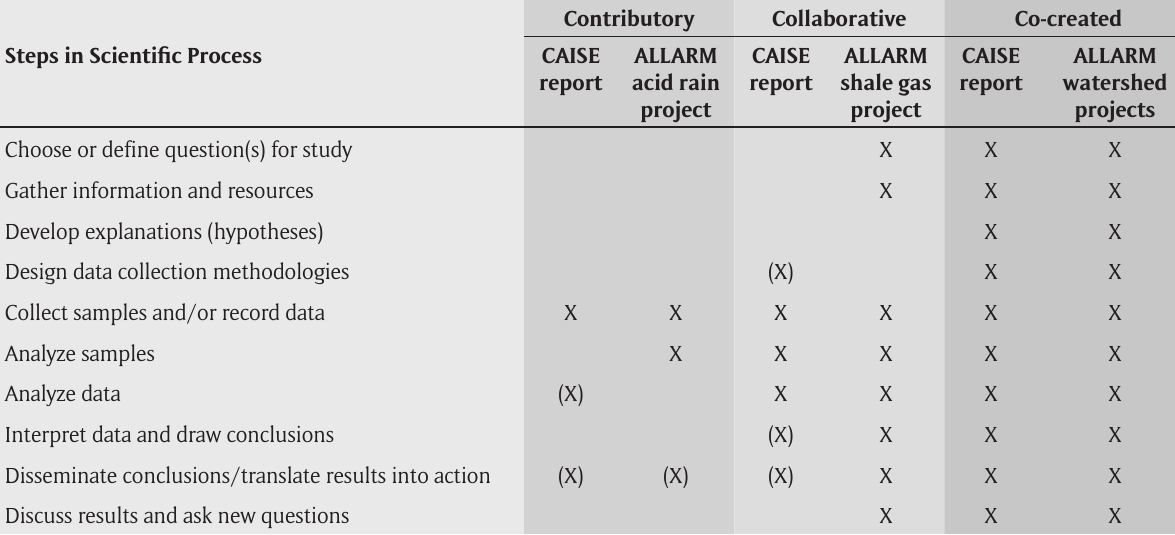
Table 1: A comparison of the general characteristics of three different models for Public Participation in Scientific Research (PPSR) from Bonney et al. (2009) with the characteristics of the ALLARM projects that fall into similar models. The Xs denote citizen participation; the parentheses around the Xs denote that some projects categorized in this model may include volunteers in this step, while others may not. The table is arranged in order of increasing community participation in the scientific process in the three models, from left to